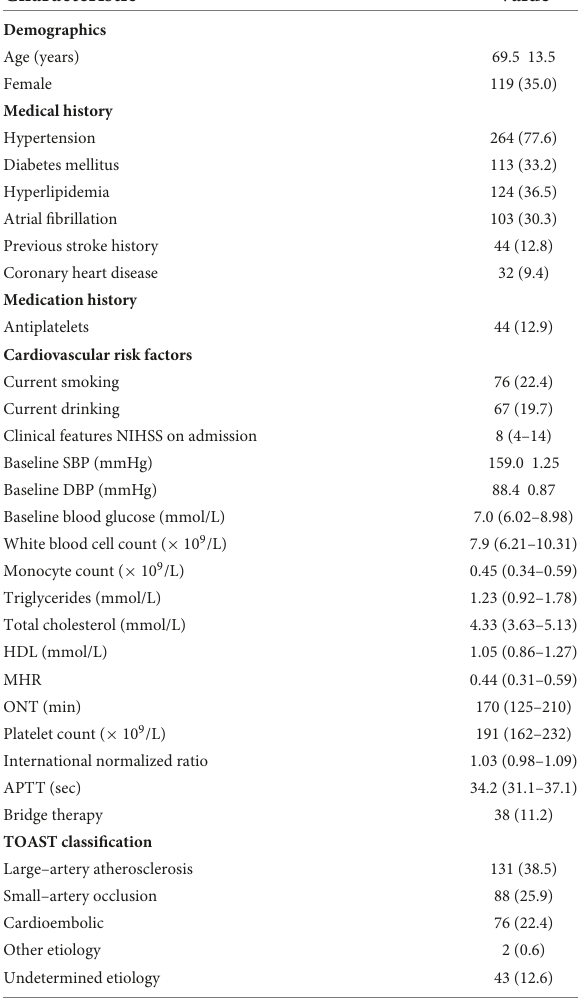
TABLE 1 Characteristics of the entire study population ( n =